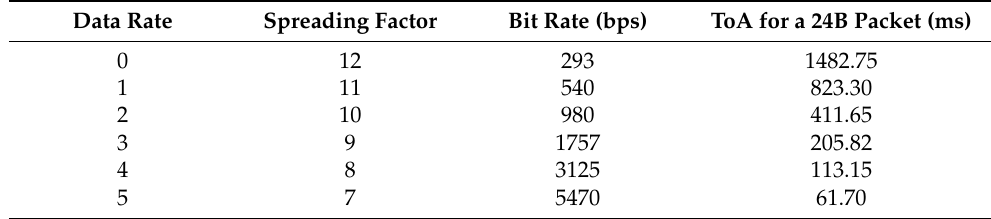
Table 1. Data Rate configuration for a 125 kHz bandwidth in the EU868 ISM band.